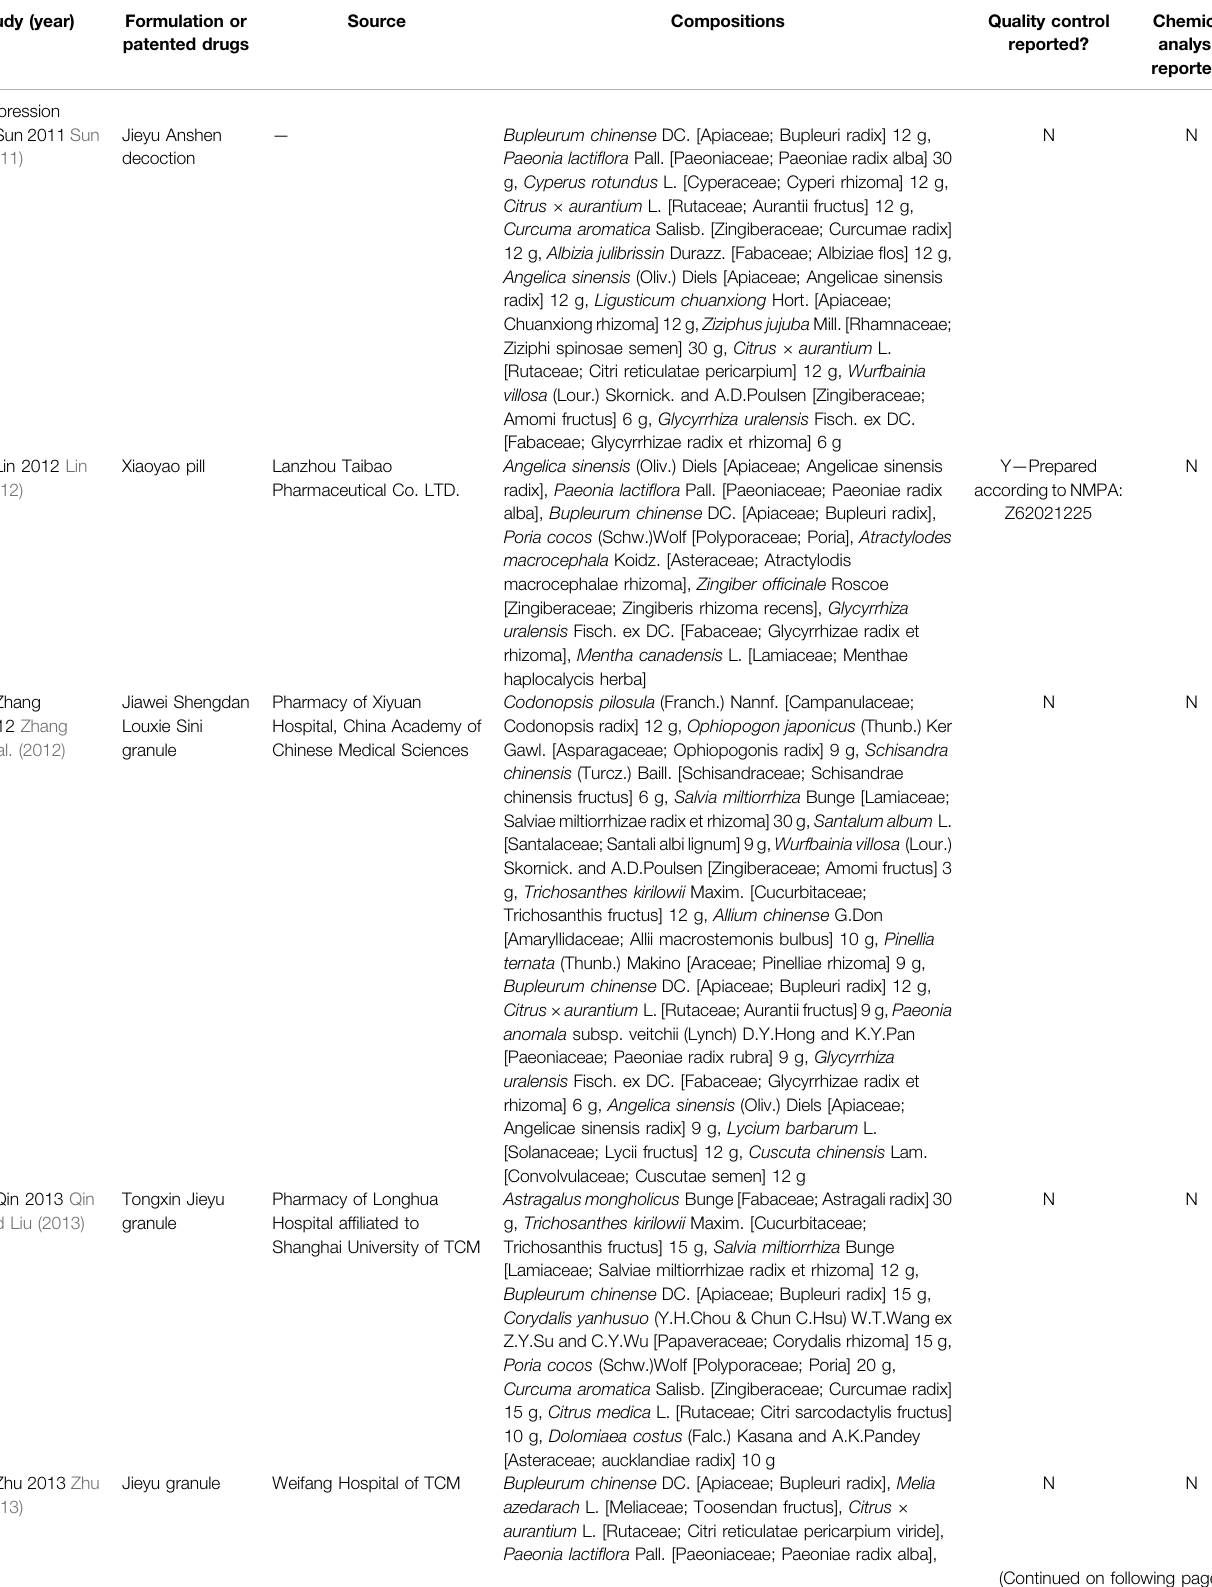
TABLE 1 | ( Continued ) Compositions of formulation and patented